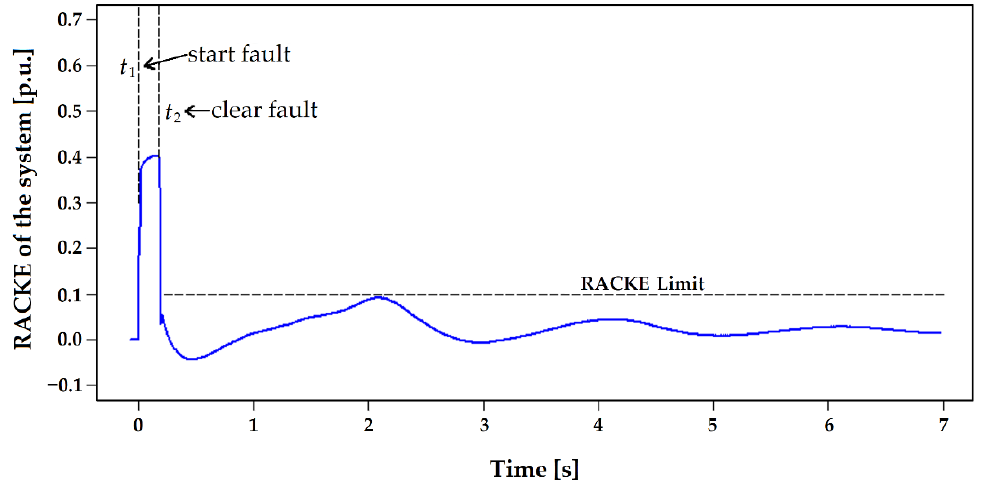
Figure 11. RACKE_SIS vs. time and the critical stable case.